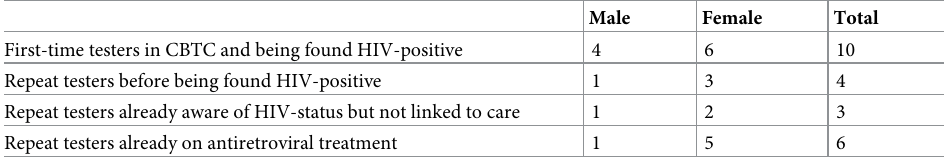
Table 2. Testing histories of IDI participants who tested positive in the CBTC (n =